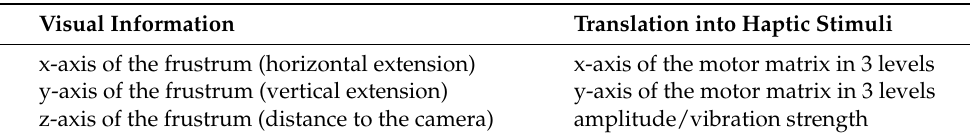
Table A1. The translation principle of the